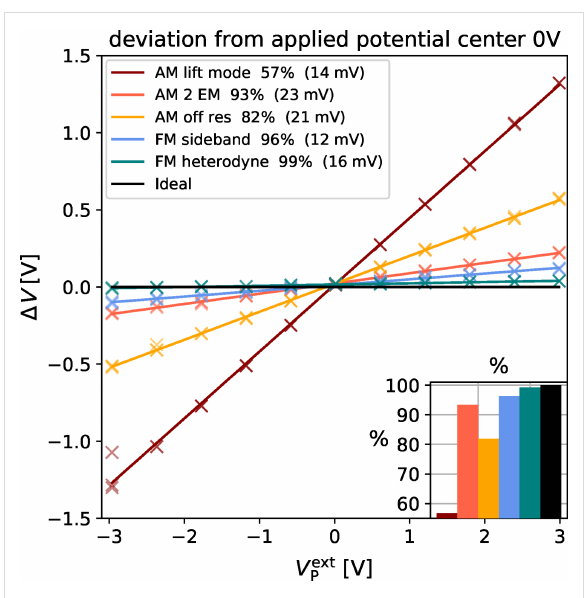
Figure 4: Comparison of the deviation of the measured potential differ- ence from the applied potential plotted against the applied potential for AM (warm colors) and FM (cool colors), black represents an ideal measurement. Inset in the lower right visualizes the fraction of the potential captured by the respective method. Legend in the upper left shows the offset in brackets. Data shown captured in the middle of the electrode structure without an additional electrostatic force.